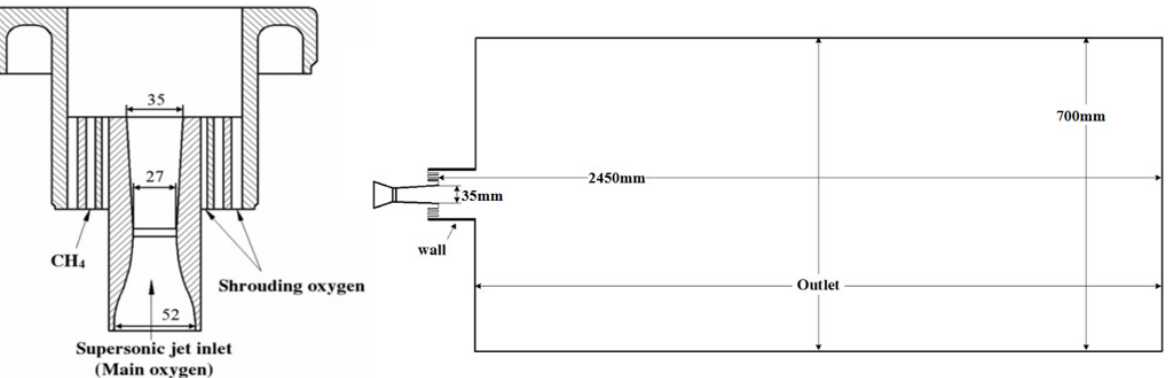
Figure 3. Cross-sectional view of the coherent jet nozzle and the jet-flow domain used for modeling.